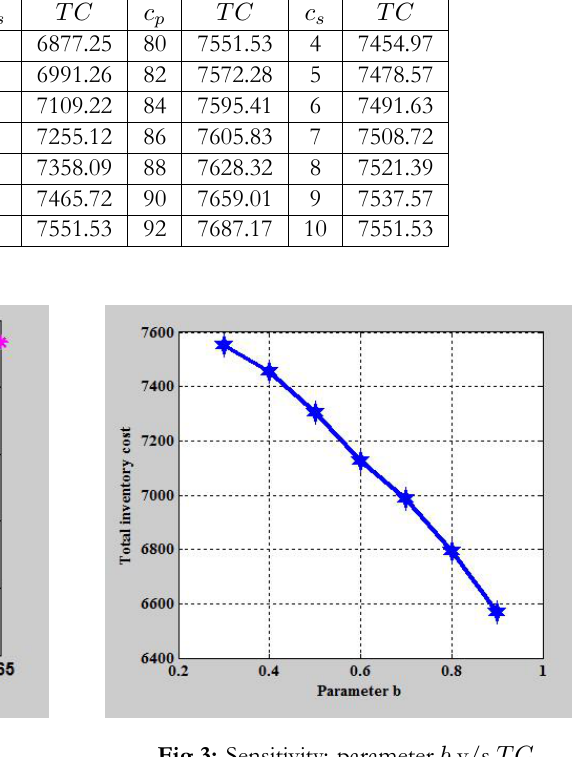
Fig 2: Sensitivity: parameter a v/s TC Fig 3: Sensitivity: parameter b v/s TC